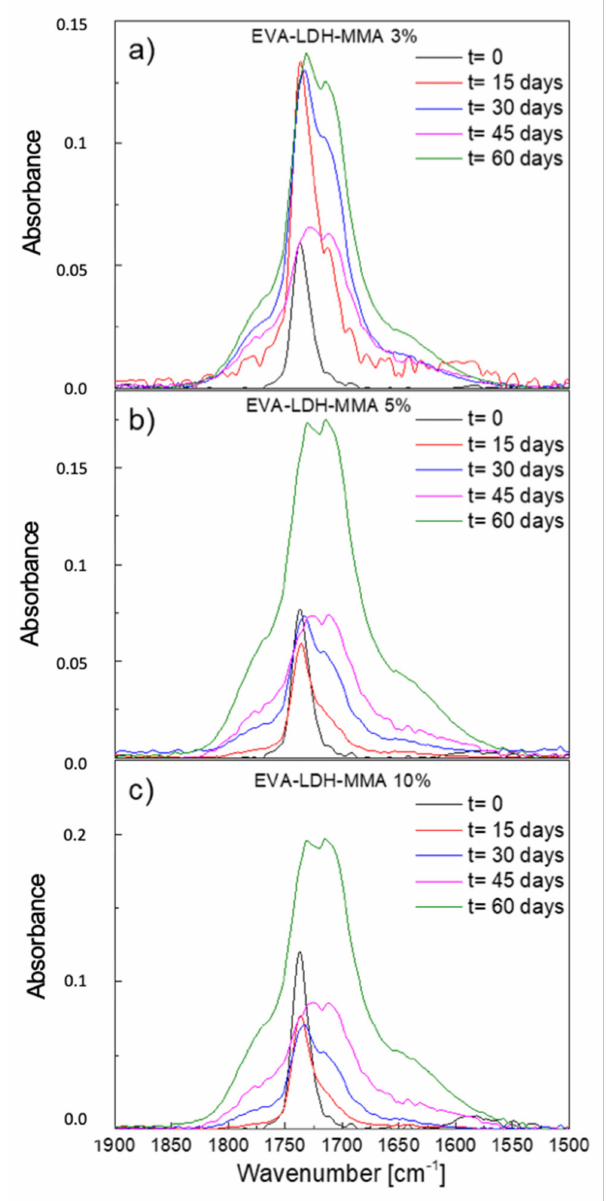
Figure 4. FT-IR spectra in the carbonyl region for EVA + LDH-MA 3% ( a ), EVA + LDH-MA 5% ( b ) and EVA + LDH-MA 10% ( c ) samples at different exposure